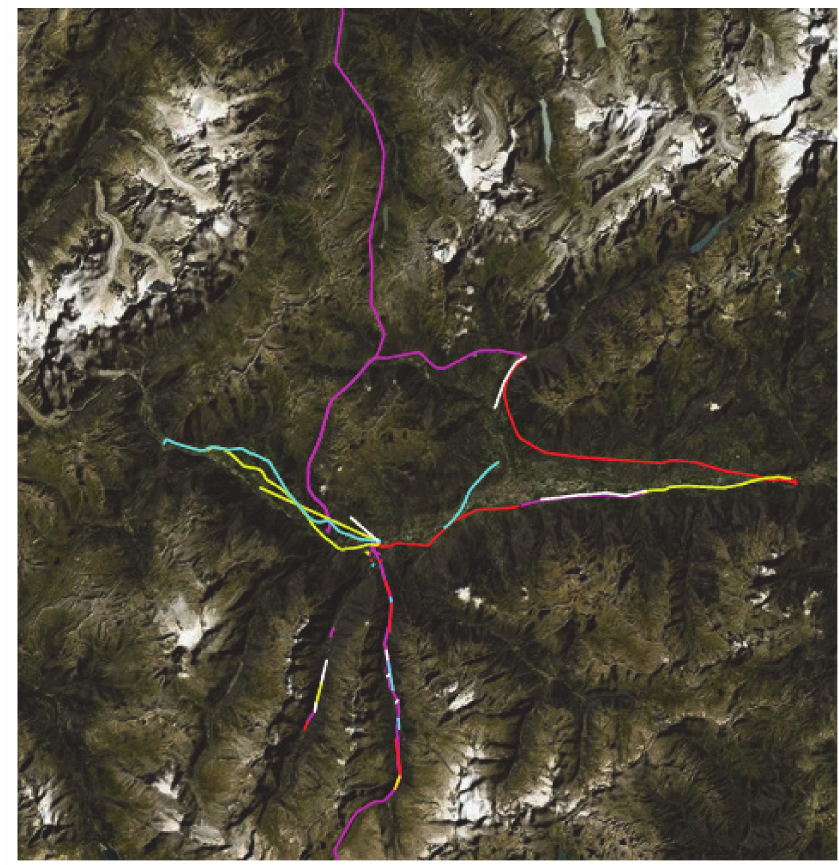
Figure 8. Geolocalization of critical components, case